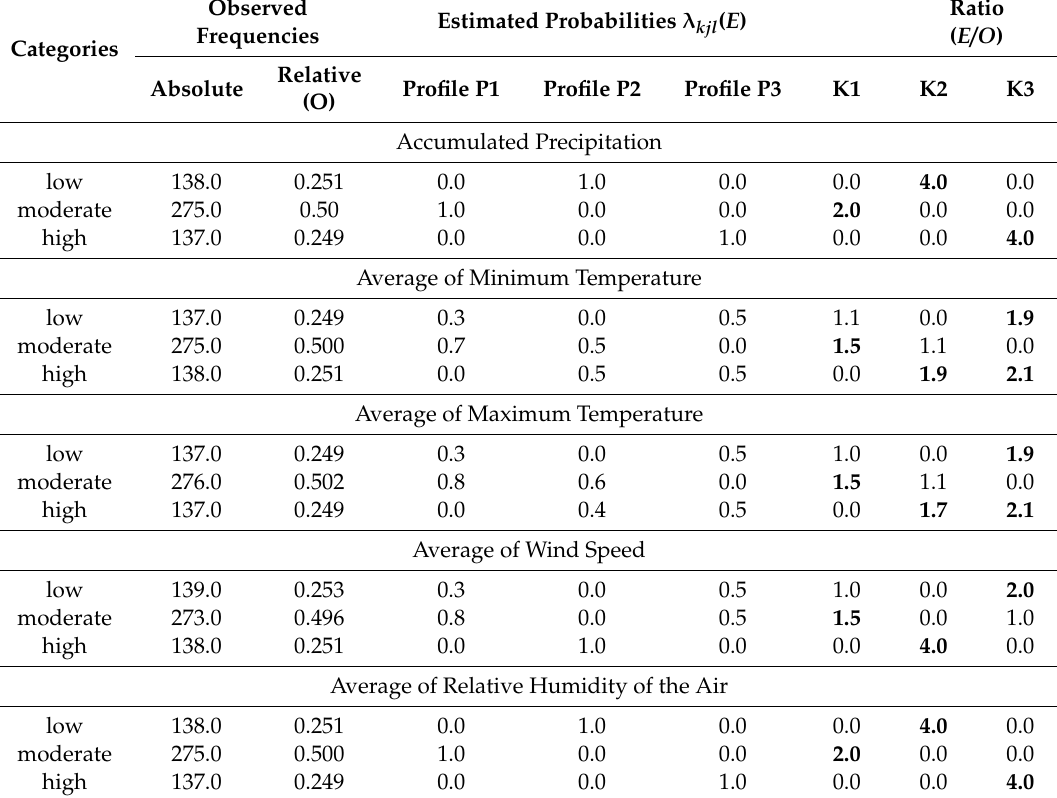
Table 1. Absolute frequencies, relatives and estimates of λ kjl , according to predominant profiles and categories of